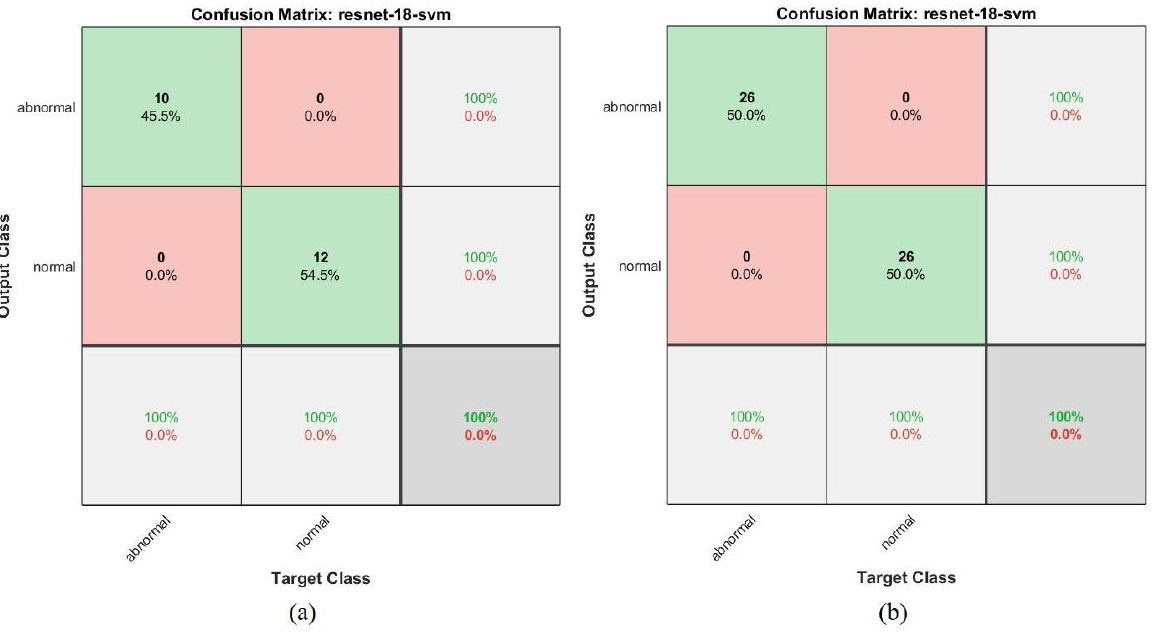
Figure 28. Confusion matrix for the ResNet-18 + SVM hybrid technique for the ( a ) ALL_IDB1 and ( b ) ALL_IDB2 datasets.